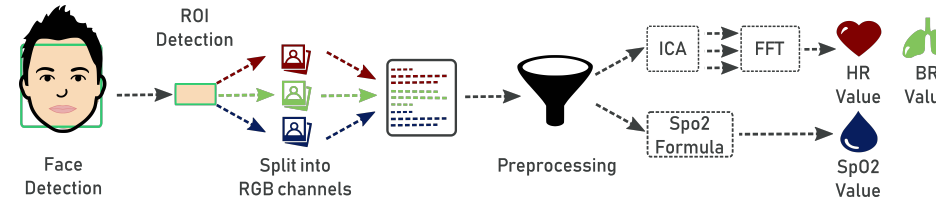
Figure 3. Pipeline to measure heart rate, breath rate and blood oxygen